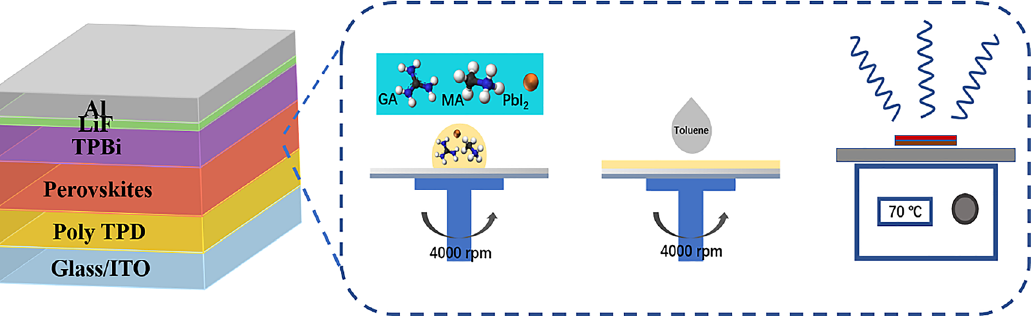
Figure 5: Schematic of the perovskite LED structure used in this work, along with the perovskite structure and fabrication process. The perovskite films were deposited by spin coating at 4000 rpm. An antisolvent step was performed by dropping toluene on the substrates 5 s after commencing spinning. The samples were then annealed at 70 ° C for 10